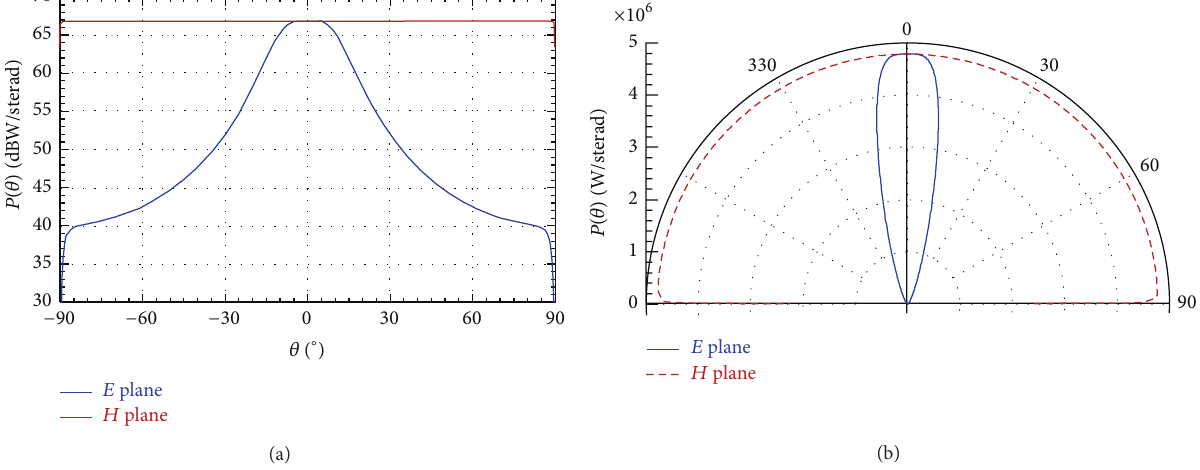
Figure 8: Radiation patterns in the 𝐸 and 𝐻 planes at 𝑓 = 1 GHz for a structure with 𝑏 = 𝜆 0 /300 and 𝐵 𝑓 = 47.75 . Log-log plot (a) and polar linear plot (b).